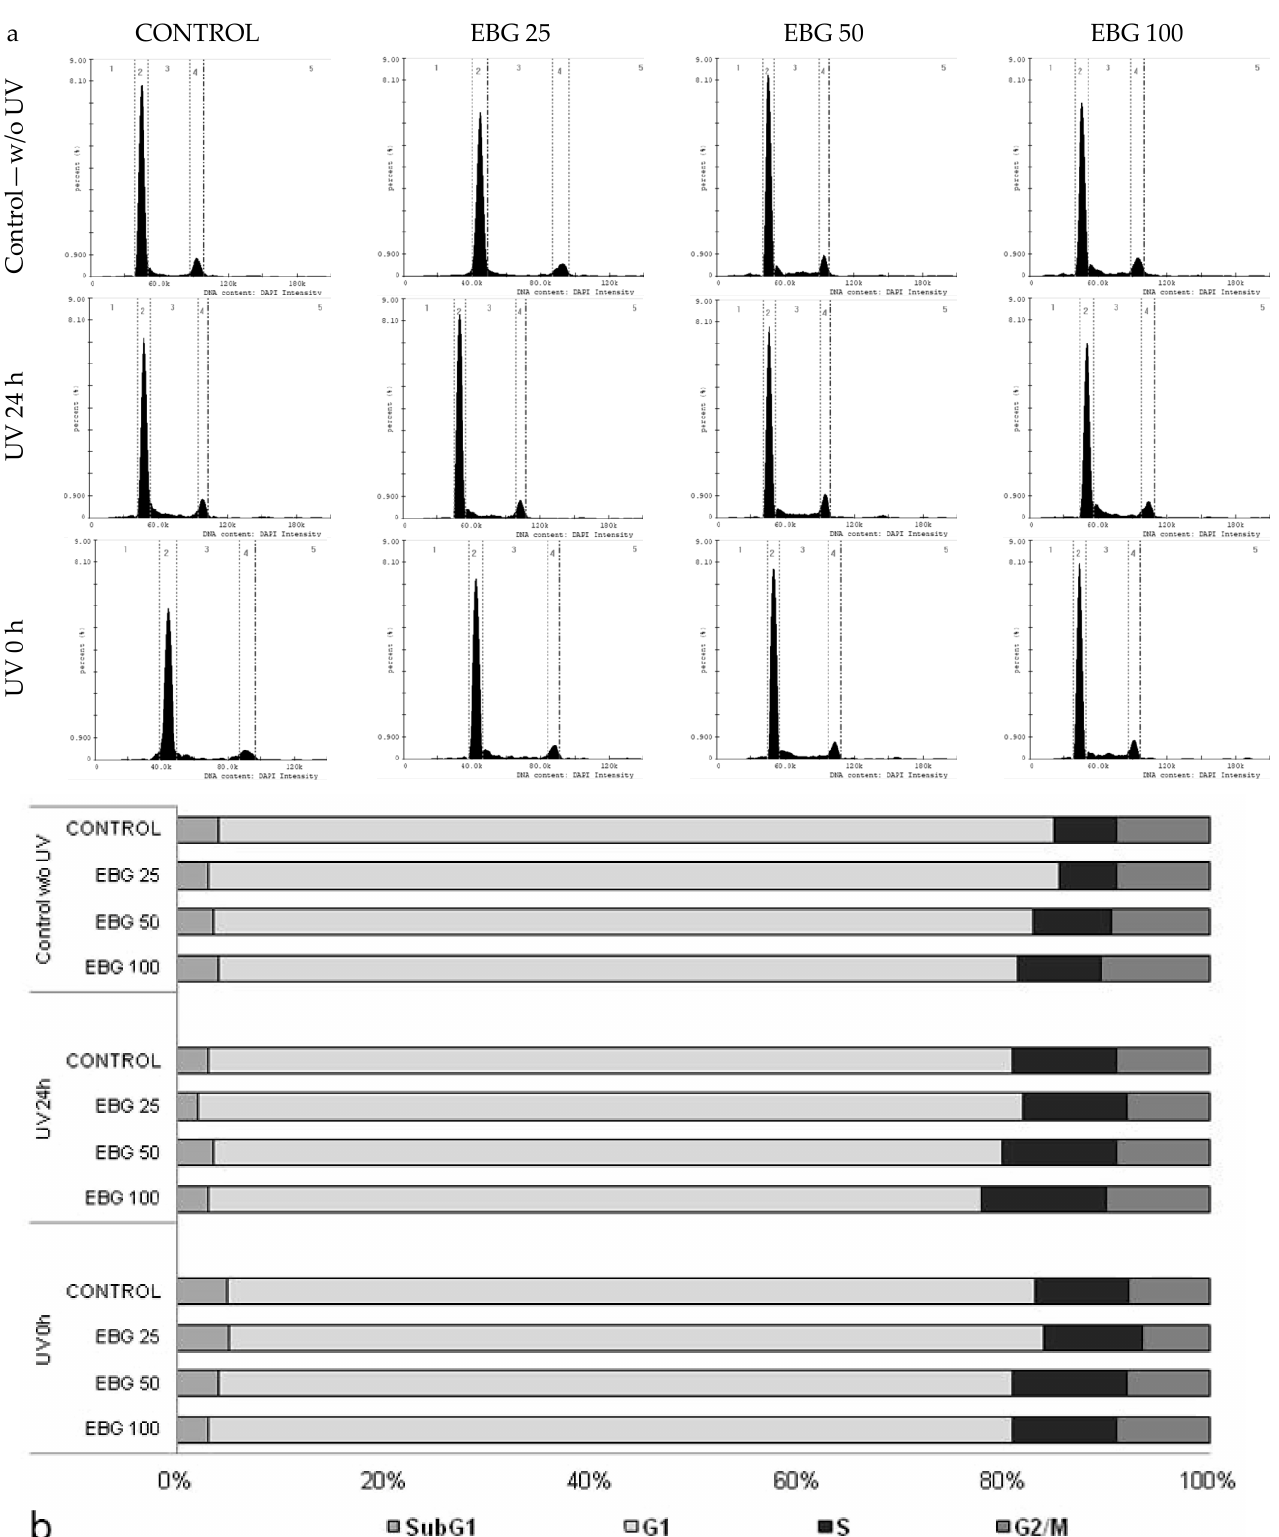
Figure 7. Analysis of cell cycle parameters in an NHSF cell line incubated for 48 h with 70% ethanolic barley grass extract (EBG) at concentrations of 25, 50 and 100 µ g/mL. Histograms ( a ) illustrate the amount of DNA based on fluorescence intensity measurements. Graph ( b ) shows the percentage distribution of cells in each phase of the cycle compared to the